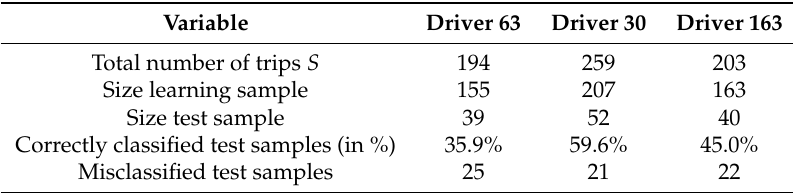
Table 4. Out-of-sample analysis of drivers 63, 30 and